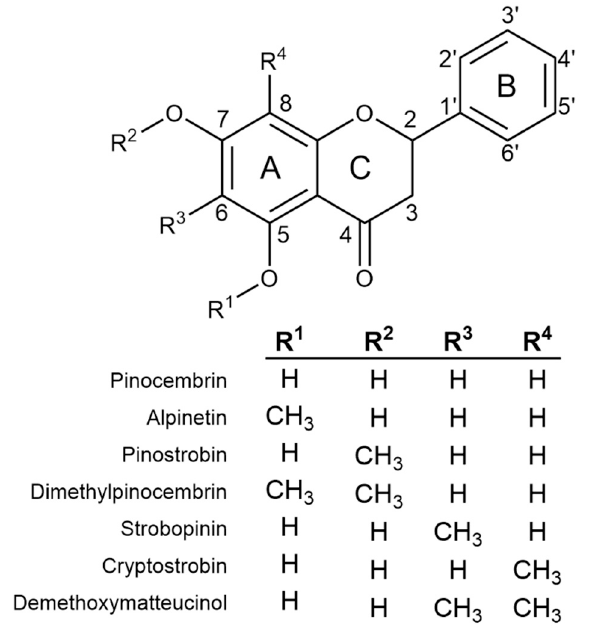
Figure 1. The chemical structure of the core flavanone pinocembrin, together with all possible monomethylated forms and the two most abundant dimethylated flavanones identified from Eucalyptus .